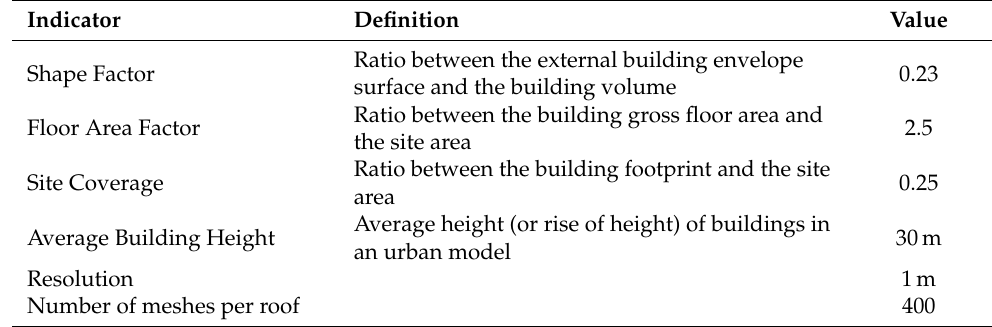
Table 1. Urban morphology indicators of the homogeneous and heterogeneous districts.